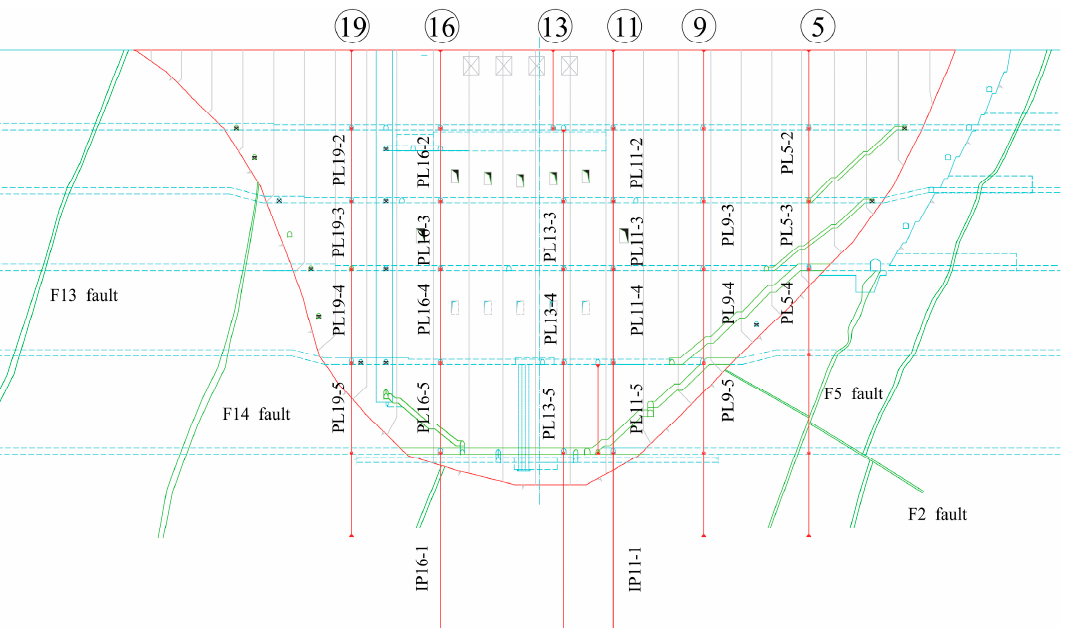
Figure 4. Actual and three-dimensional modeling drawing of the double-curved arch dam.